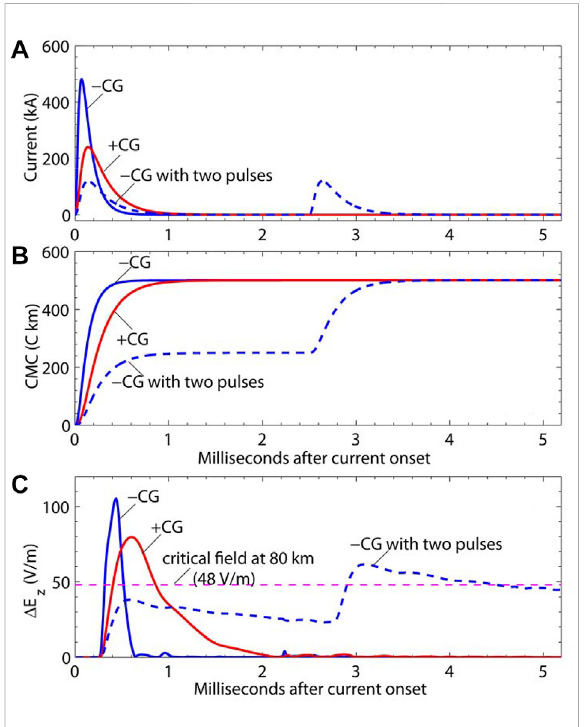
FIGURE 4 Vertical E- fi eld perturbation caused by lightning current moment with different forms: type 1 for normal negative CG strokes, type 2 for normal positive CG strokes, and type 3 for a negative CG stroke with two consecutive current pulses as discussed by Lu et al. (2016). The current waveform of each type is shown in panel (A) , and the lightning channel is assumed to be vertical with a length of 5 km. The cumulated charge moment change (CMC) and resulted E- fi eld perturbation at 80 km altitude are shown in panels (B,C) ,